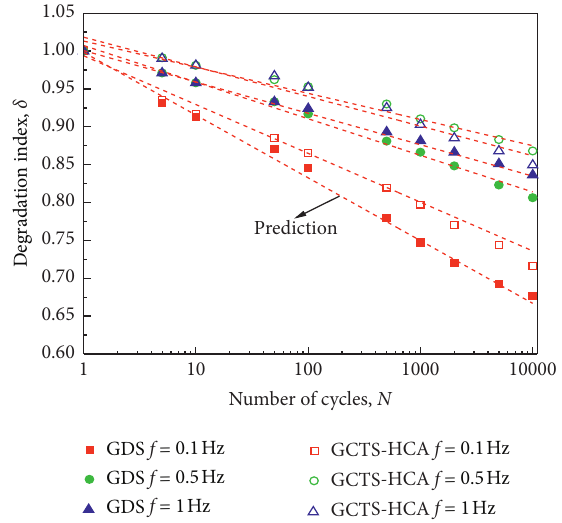
Figure 9: Results under different test